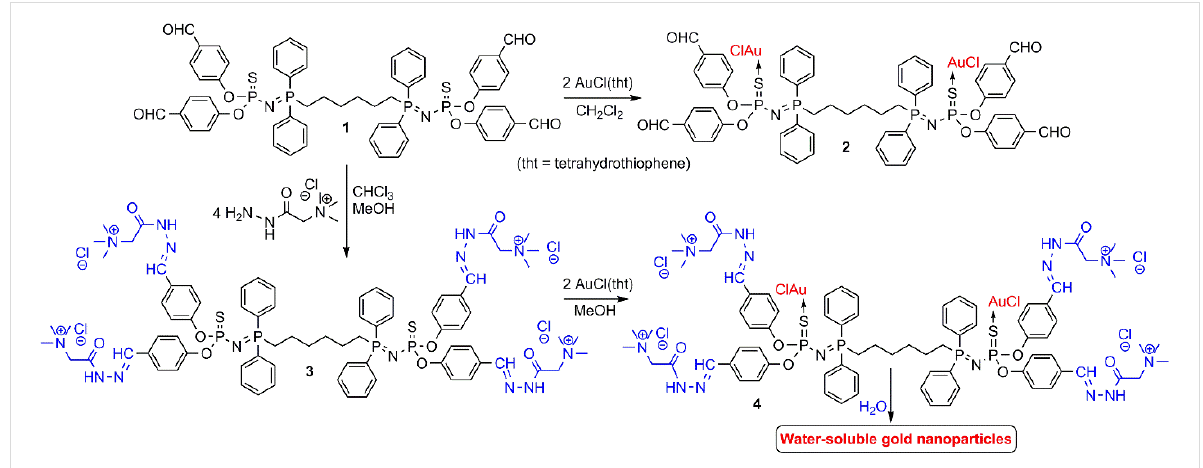
Figure 1: Synthesis of the small phosphorus dendrimers and their complexation with gold toward the synthesis and stabilization of gold nanoparticles in water.